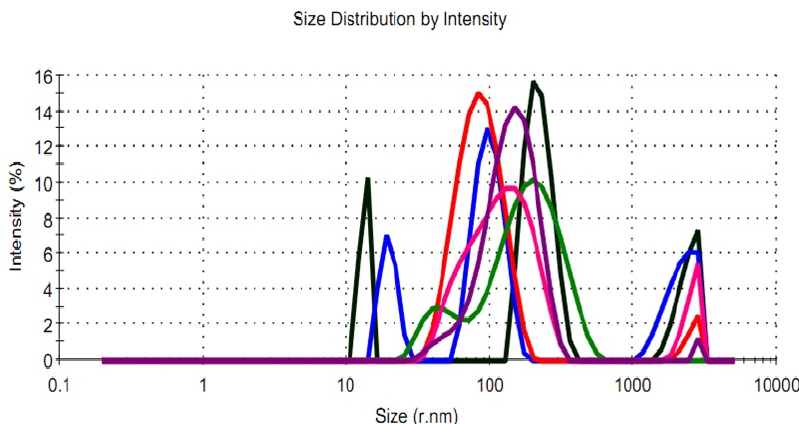
Fig. 5 Particle size by DLS for (a) undoped and 20%Yb 3+ /2%Er 3+ doped NaLuF 4 nanocrystals with different Gd 3+ contents: (b) 0% (c) 10% (d) 20% (e) 30% (f) 45%